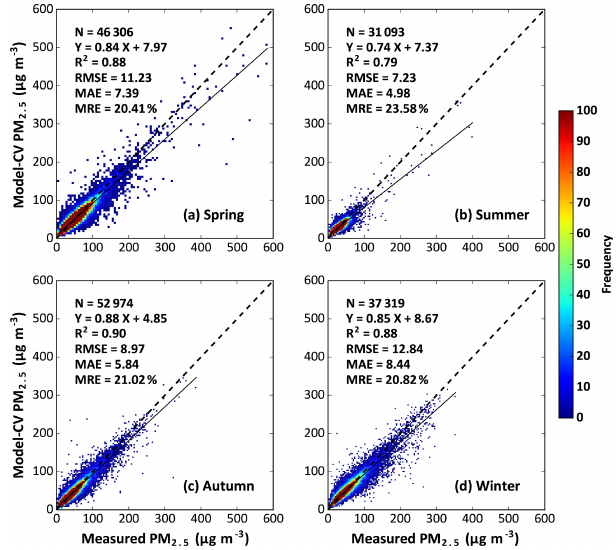
Figure 9. Density scatter plots of sample-based 10-CV results for the STET model for the four seasons in 2018 across China. Statisti- cal metrics are given in each panel, along with the linear regression relation, including the number of samples ( N ), the correlation of determination ( R 2 ), the root-mean-square error (RMSE), the mean absolute error (MAE) and the mean relative error